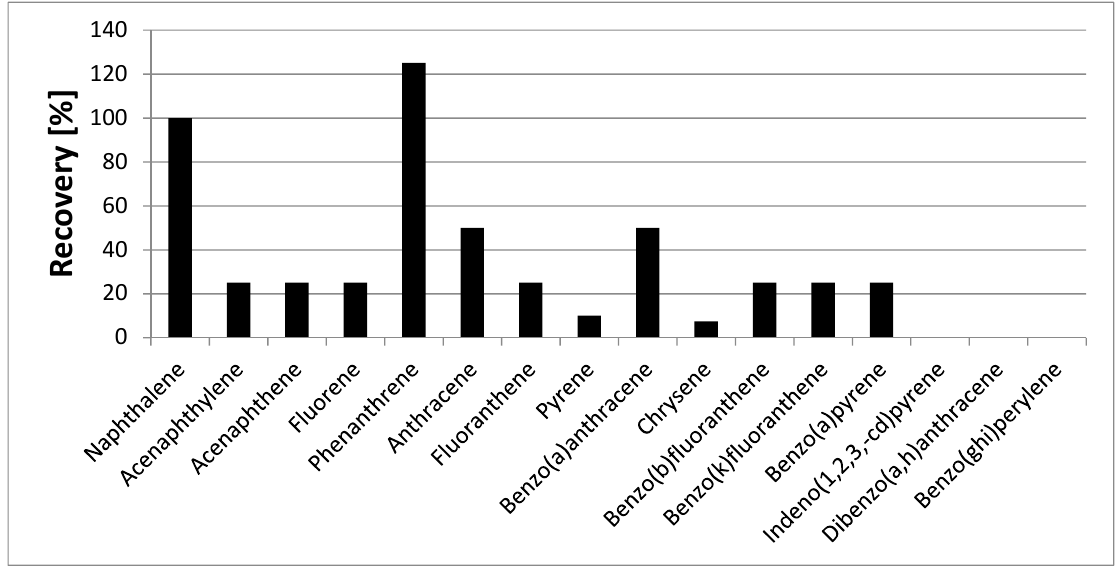
Figure 1. Recovery of PAH (polycyclic aromatic hydrocarbons).